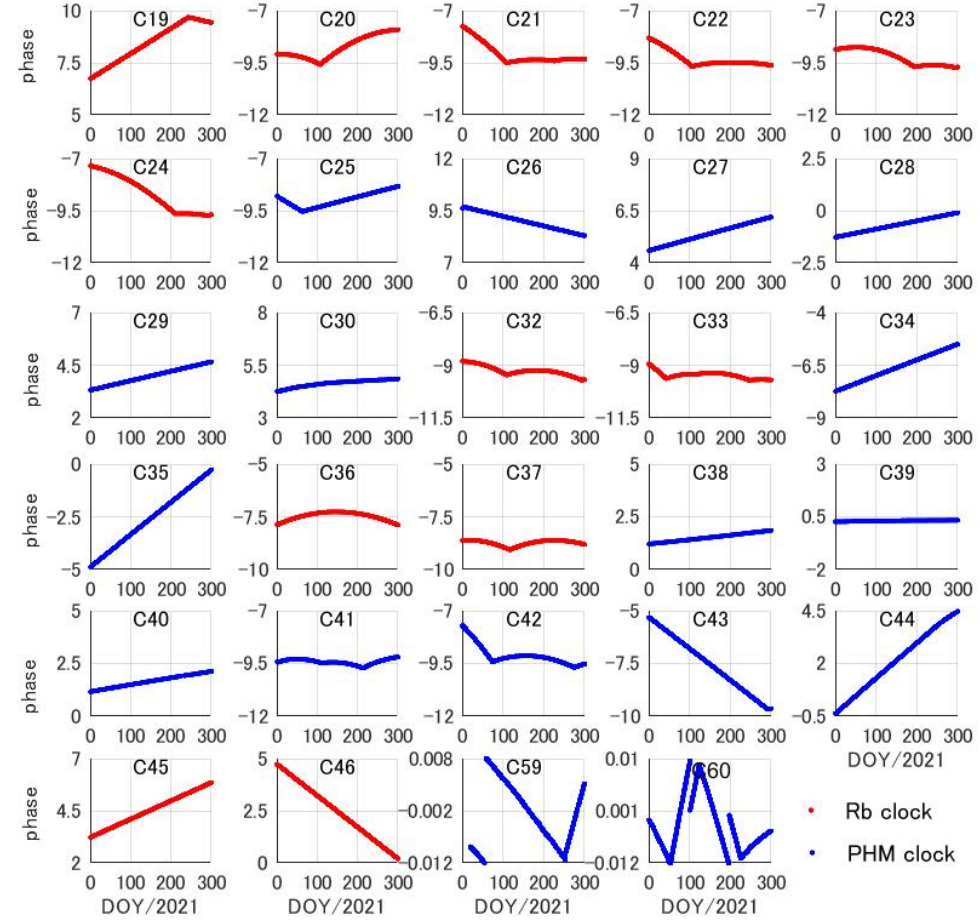
Figure 2. Clock bias series of the BDS-3 onboard clocks from DOY 1 to 300, 2021 (units: 10 (cid:2879)(cid:2872)